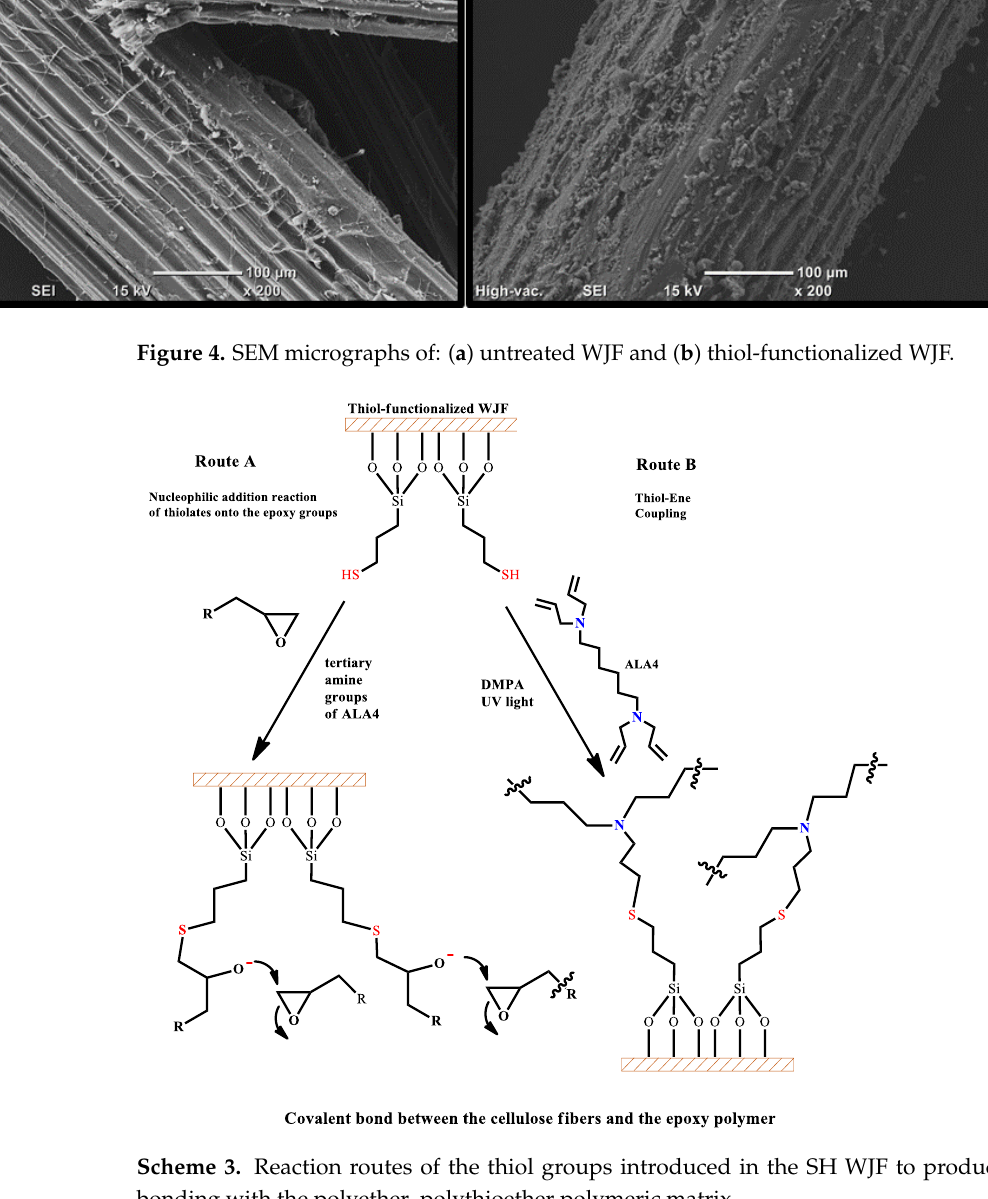
Figure 4. SEM micrographs of: ( a ) untreated WJF and ( b ) thiol-functionalized WJF.